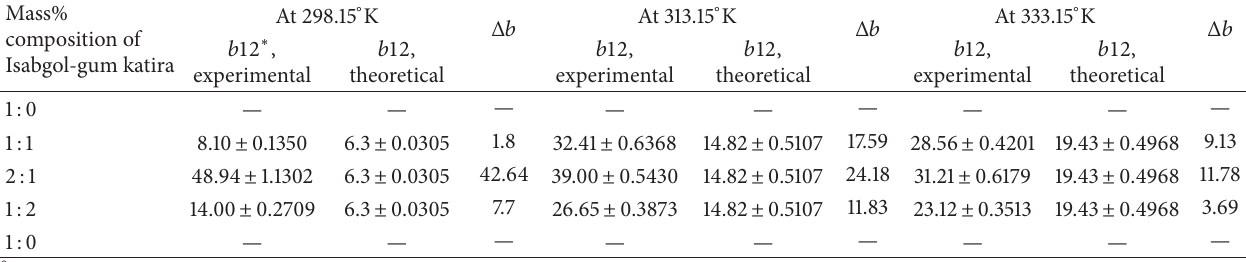
Table 2: Miscibility parameters of Isabgol husk and gum katira blends at 298.15 ∘ K, 313.15 ∘ K, and 333.15 ∘ K. Mass% composition of